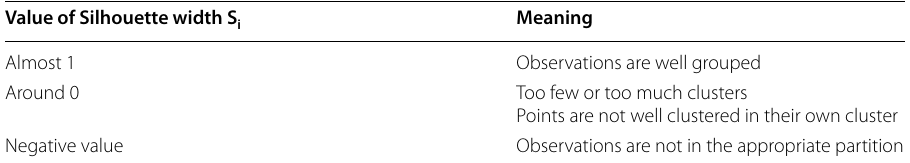
Table 9 Different values of Silhouette width in clustering models Value of Silhouette width S